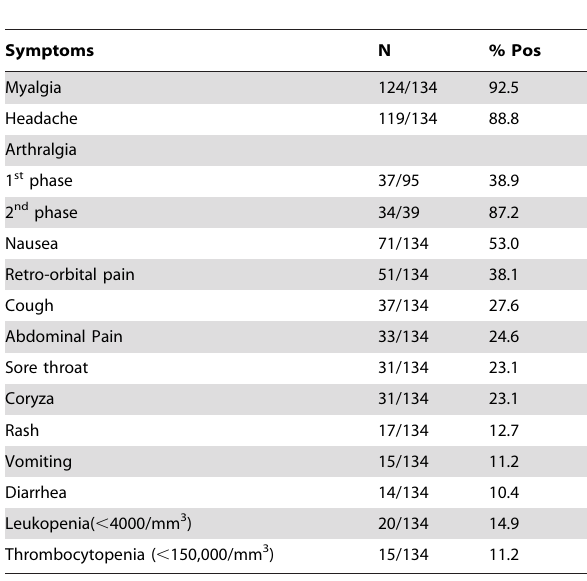
Table 1. Signs, symptoms and laboratory results for CHIK cases.